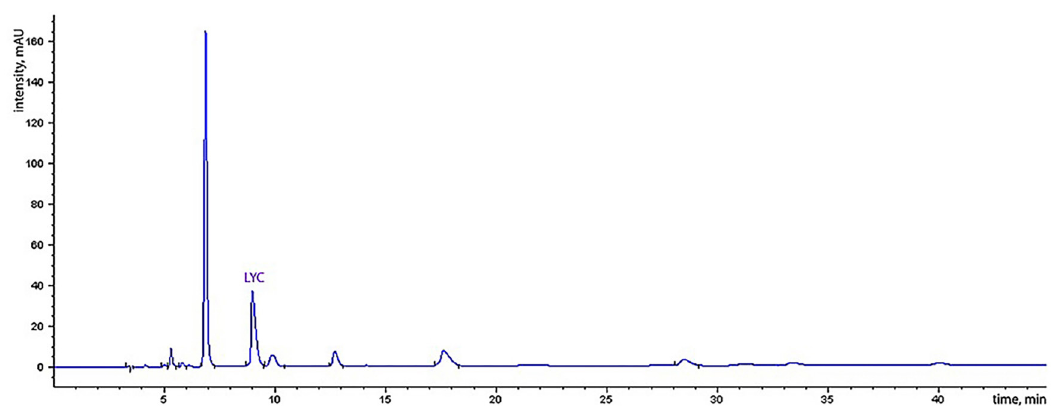
FIGURE 3 - Chromatogram of an extract of G. elwesii.